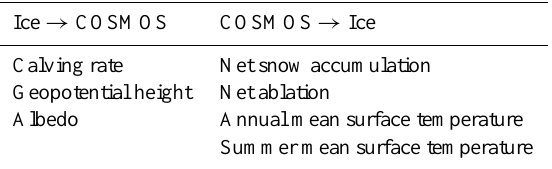
Table 1. Data exchanged in each coupling step, depending on the direction of